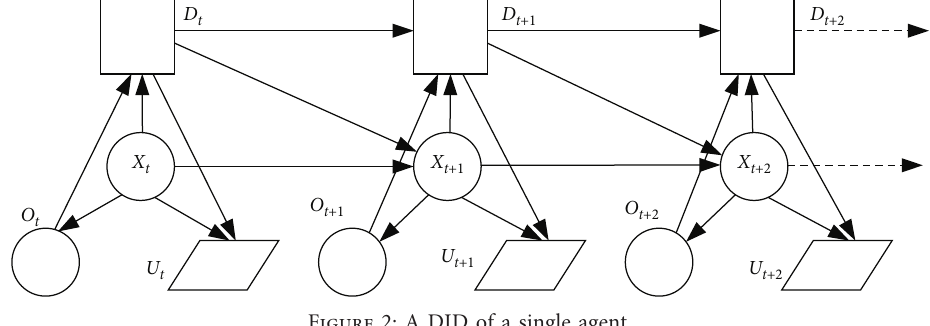
Figure 2: A DID of a single agent.